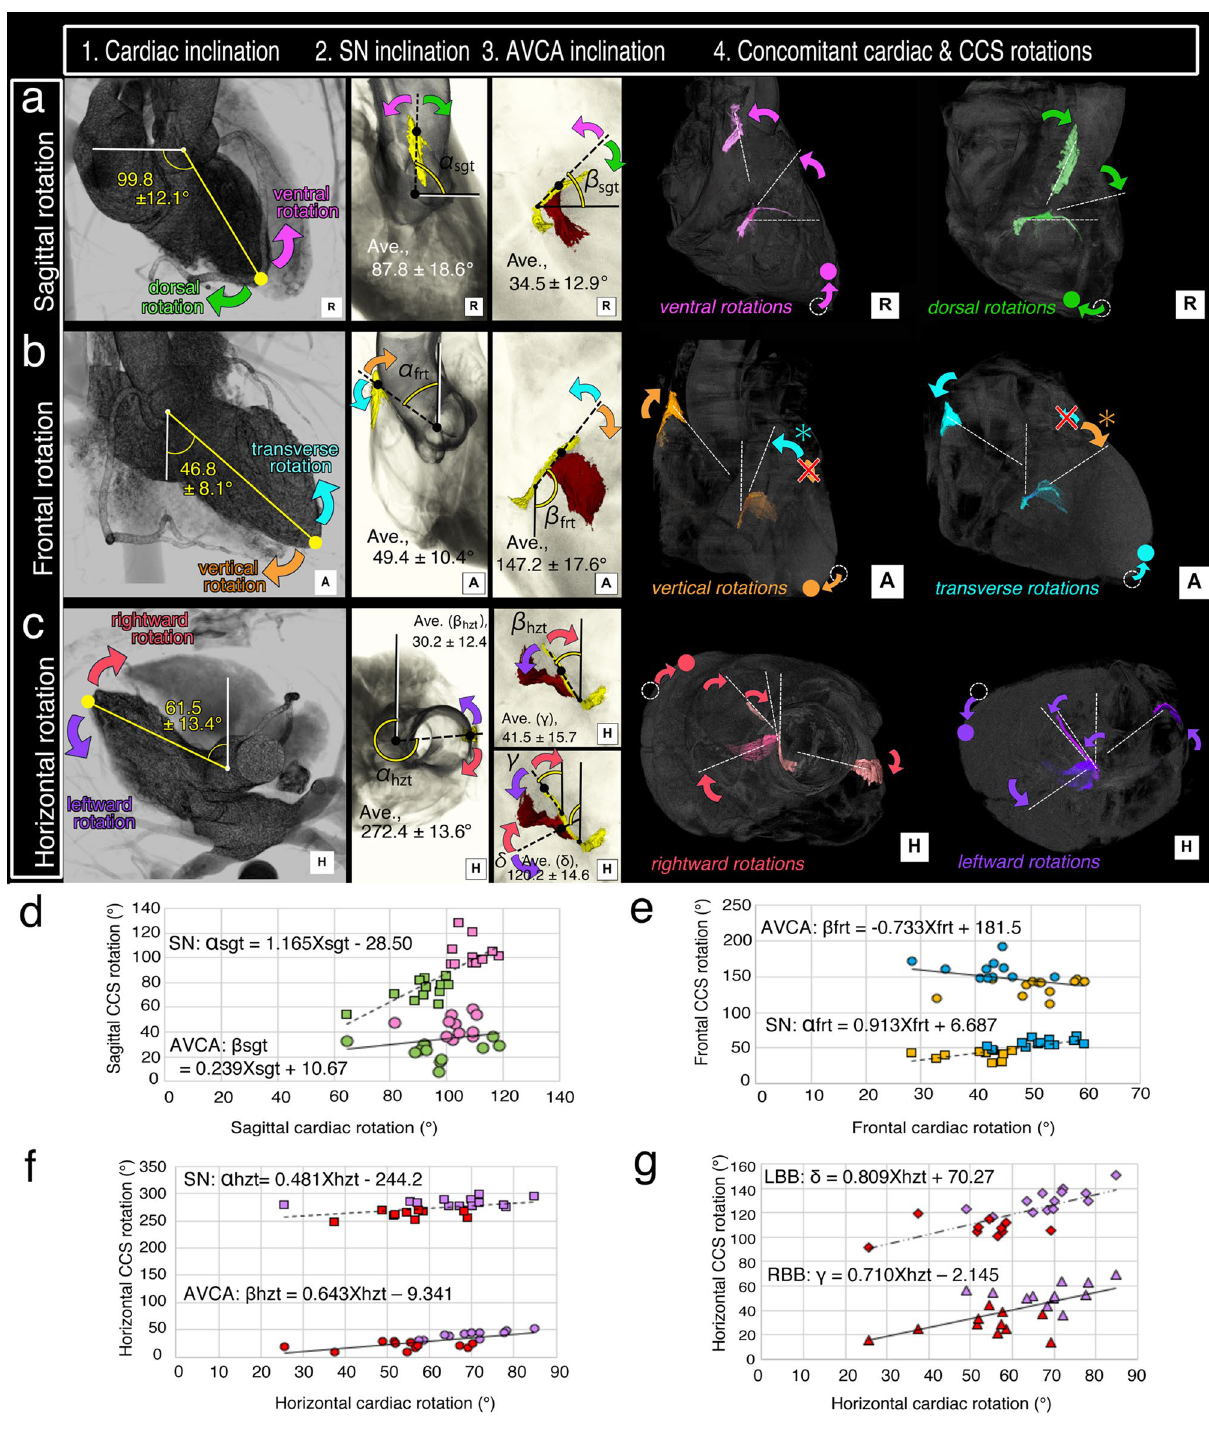
Figure 2. The 2D projection images based on the 3D CCS transformation by cardiac rotation along the 3 axes in the sagittal ( a ), frontal ( b ), and horizontal ( c ) planes of the thorax ( a – c ). Each column shows the cardiac inclination/rotation (column 1), the sinus node (SN) inclination (column 2), the atrioventricular conduction axis (AVCA) inclination (column 3), and the concomitant cardiac and CCS rotations (column 4). The colors of the rotating arrows in rows ( a – c ) indicate the direction of the cardiac and CCS rotations: pink, ventral rotation; green, dorsal rotation; orange, vertical rotation; blue, transverse rotation; red, rightward rotation; purple, leftward rotation. Scatterplot graphs showing the relationship between angles of cardiac and CCS component rotations in the sagittal ( d ), frontal ( e ) , and horizontal rotations ( f,g ) of all examined hearts. The dashed (SN) and solid (AVCA) lines are the lines of best-fit from the linear regression analysis. The scatterplot colors represent the same colors used for cardiac rotations. AVCA atrioventricular conduction axis, LBB left bundle branch, RBB right bundle branch, SN sinus